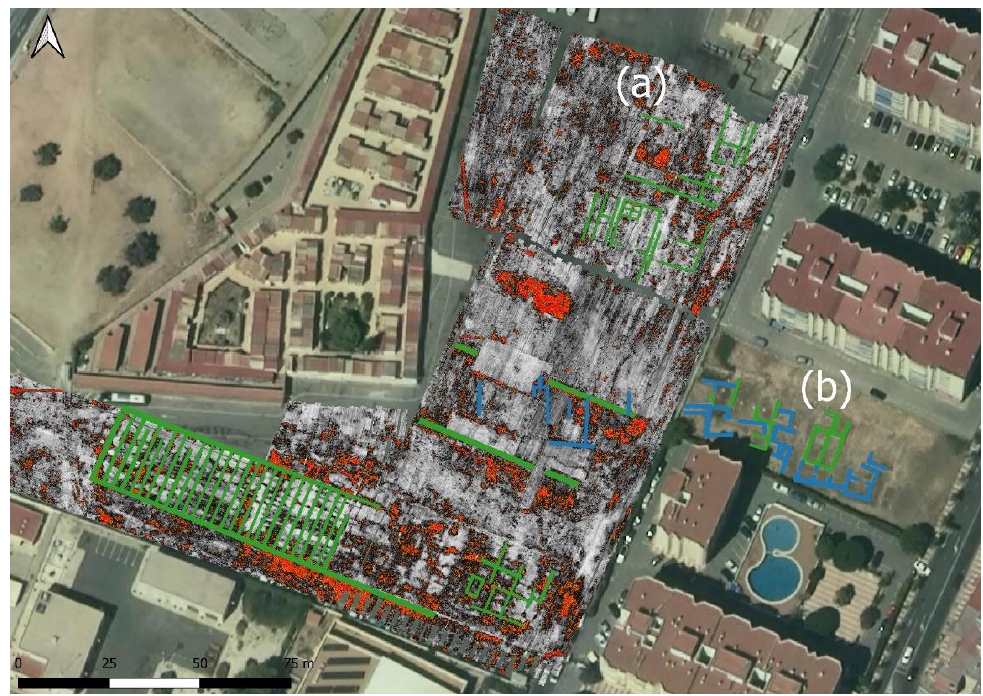
Figure 13. (a) View of the study area showing in green and blue the two orientations observed in the main alterations. (b) Site of the Portus Ilicitanus plot showing the excavated structures from the Early Empire (in green) and the Late Empire (in blue).